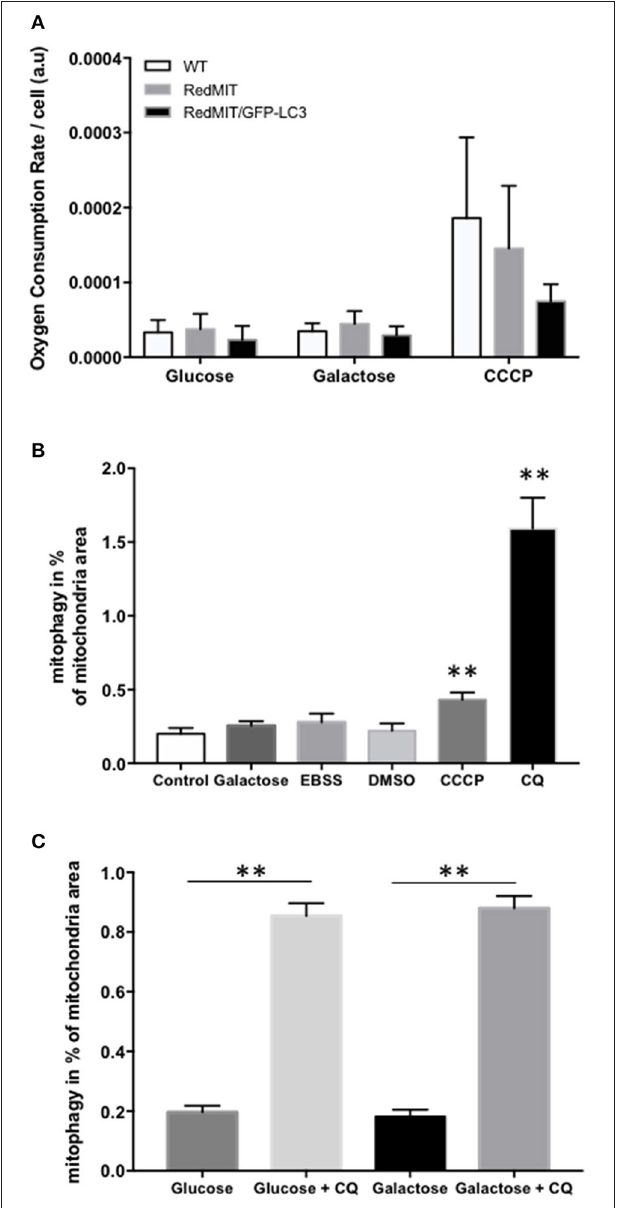
FIGURE 2 | Validation of the RedMIT-GFP-LC3 Mouse model for detecting mitophagy (see Diot et al., 2015 for detailed validation of high throughput imaging to quantify mitophagy). (A) MEFs from WT, RedMIT and RedMIT-GFP-LC3 mice were used to clarify whether expressing mRFP in mitochondria impaired their function. No significant differences in oxygen consumption were observed either in glycolytic (Glucose), oxidative (Galactose), or uncoupled (CCCP) conditions [mean + SD, n = 2, t -test p = 0.625–0.684–0.289 for wt vs. RedMIT-GFP-LC3/0.832–0.559–0.714 for wt vs. RedMIT/0.532–0.409–0.369 for RedMIT vs. RedMIT-GFP-LC3 (glucose—galactose—CCCP, respectively)]. (B) Using our IN Cell 1000 high-throughput microscopy assay (Diot et al., 2015) we validated detection of mitophagy in RedMIT-GFP-LC3 MEFs grown for 2h in glucose media (control), glucose-free galactose-based media (galactose), starvation media (EBSS), media containing vehicle (DMSO), glucose media supplemented with 10 µ M CCCP (CCCP), and glucose media supplemented with 25 µ M chloroquine (Continued)